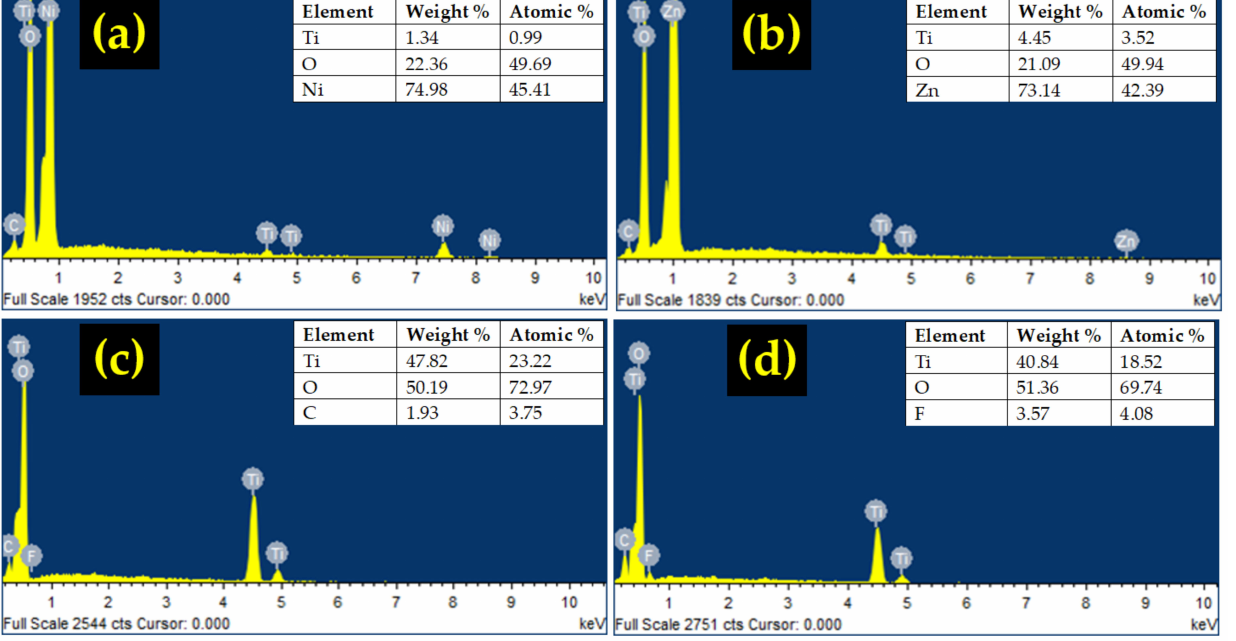
Figure 4. EDS analysis of: ( a ) TiO 2 /NiO, ( b ) TiO 2 /ZnO, ( c ) TiO 2 /rGO, and ( d ) TiO 2